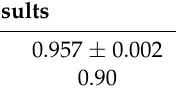
Table 3. Fitting parameters and results.